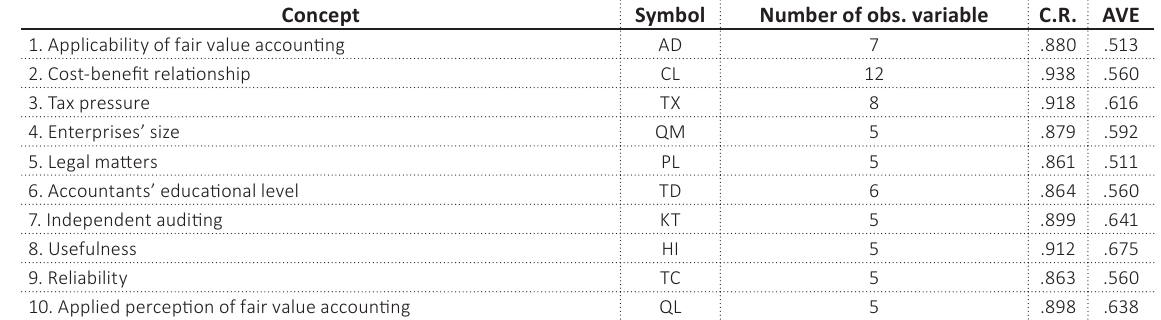
Table 2. Reliability and convergence of the scale